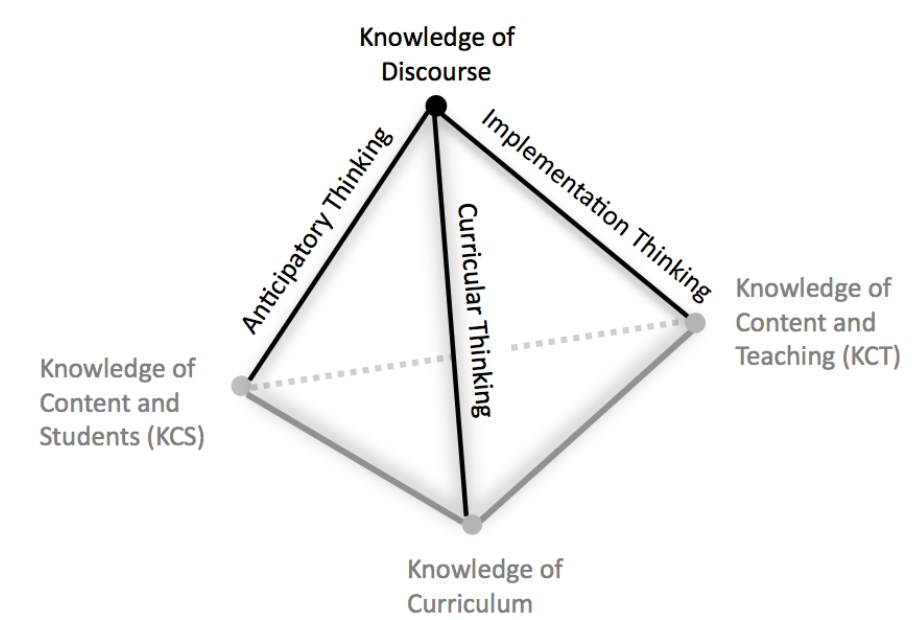
Figure 3. Tetrahedron - vertices, edges, and surfaces - as a way to visualize PCK components and relationships. Corners of the base are PCK dimensions from Figure